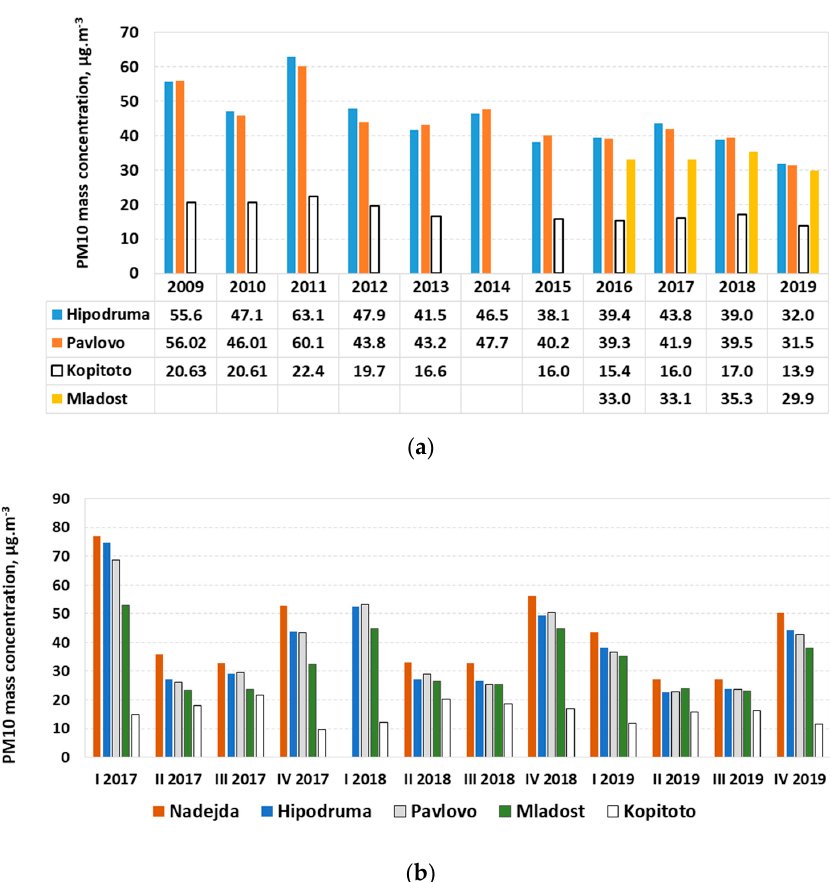
Figure 3. Mean annual ( a ) and mean quarterly ( b ) PM10 concentrations in AMS .